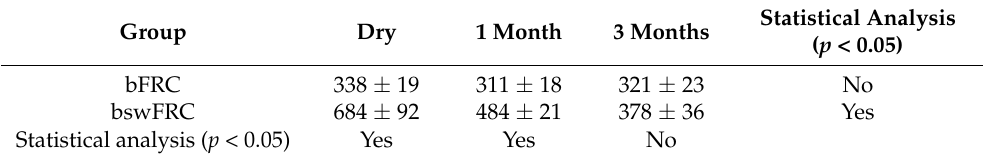
Statistical Analysis ( p < 0.05) Yes